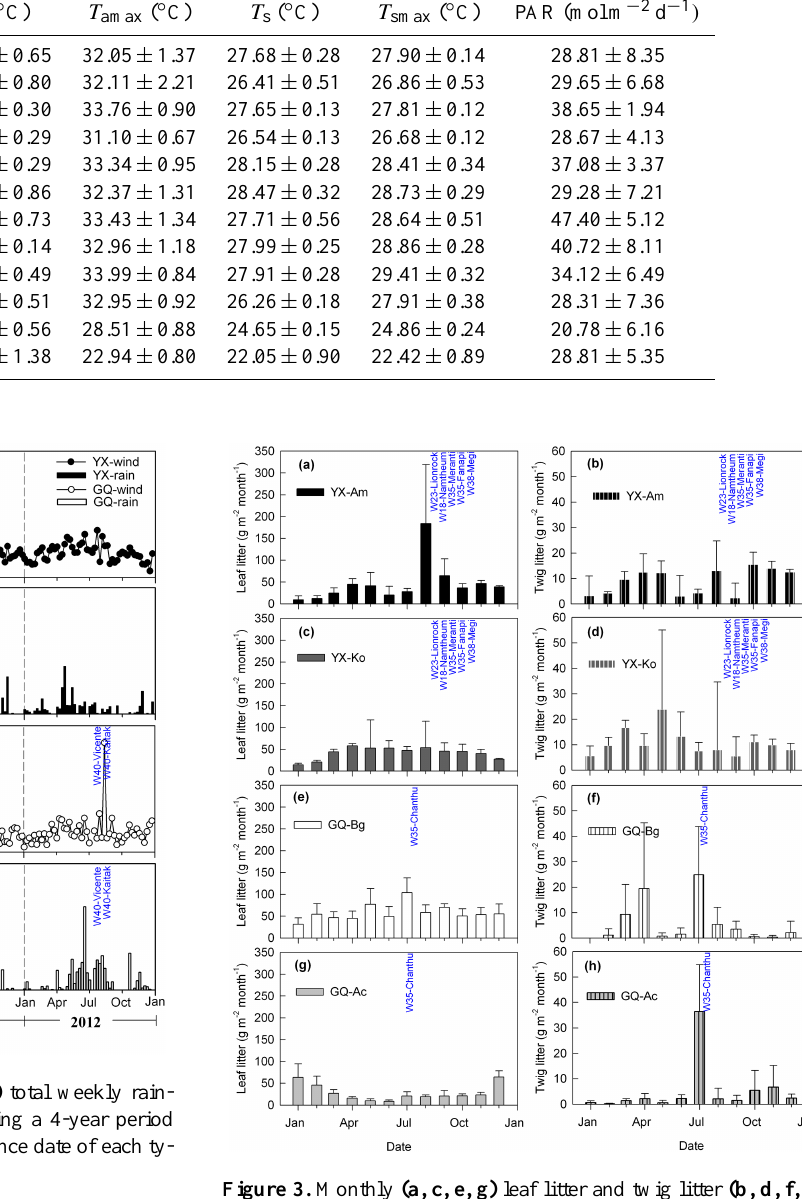
Figure 3. Monthly (a, c, e, g) leaf litter and twig litter (b, d, f, h) production for Yunxiao (YX) and Gaoqiao (GQ) in 2010. YX-Am: Avicennia marina at YX, YX-Ko: Kandelia obovata at YX, GQ-Bg: Bruguiera gymnorrhiza at GQ, GQ-Ac: Aegiceras corniculatum at GQ. The name and occurrence date of each typhoon are also